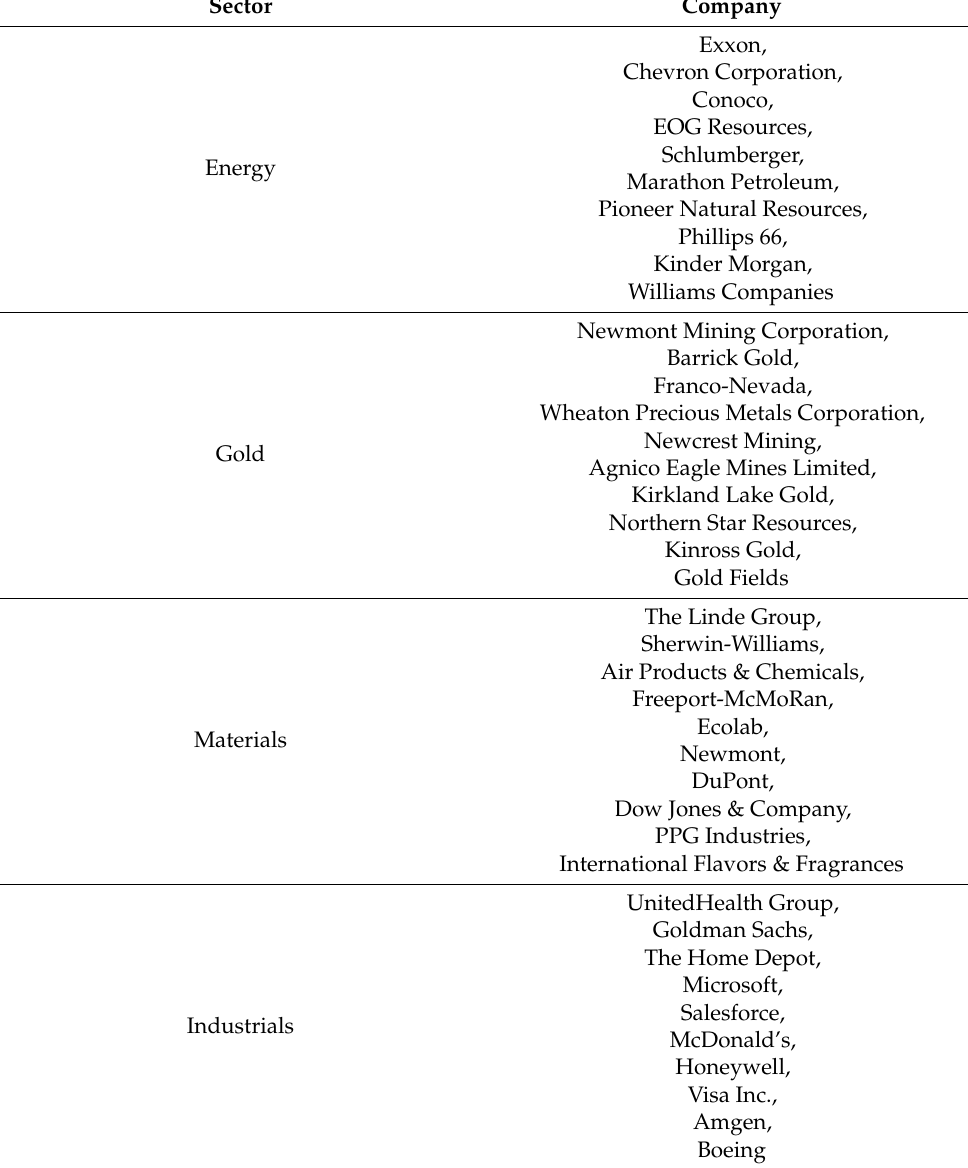
Table A1. Top 10 company holdings for